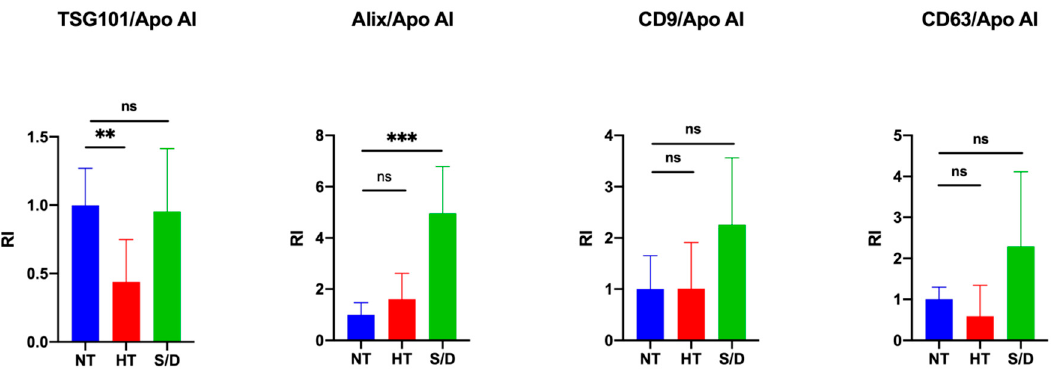
Figure 3. Quantification of blotted protein bands and ratio between EV luminal markers TSG101/Alix and EV surface markers CD9CD63 with contaminant lipoprotein Apo AI. Significance level: p < 0.05; ** = p < 0.01; *** = p < 0.001.